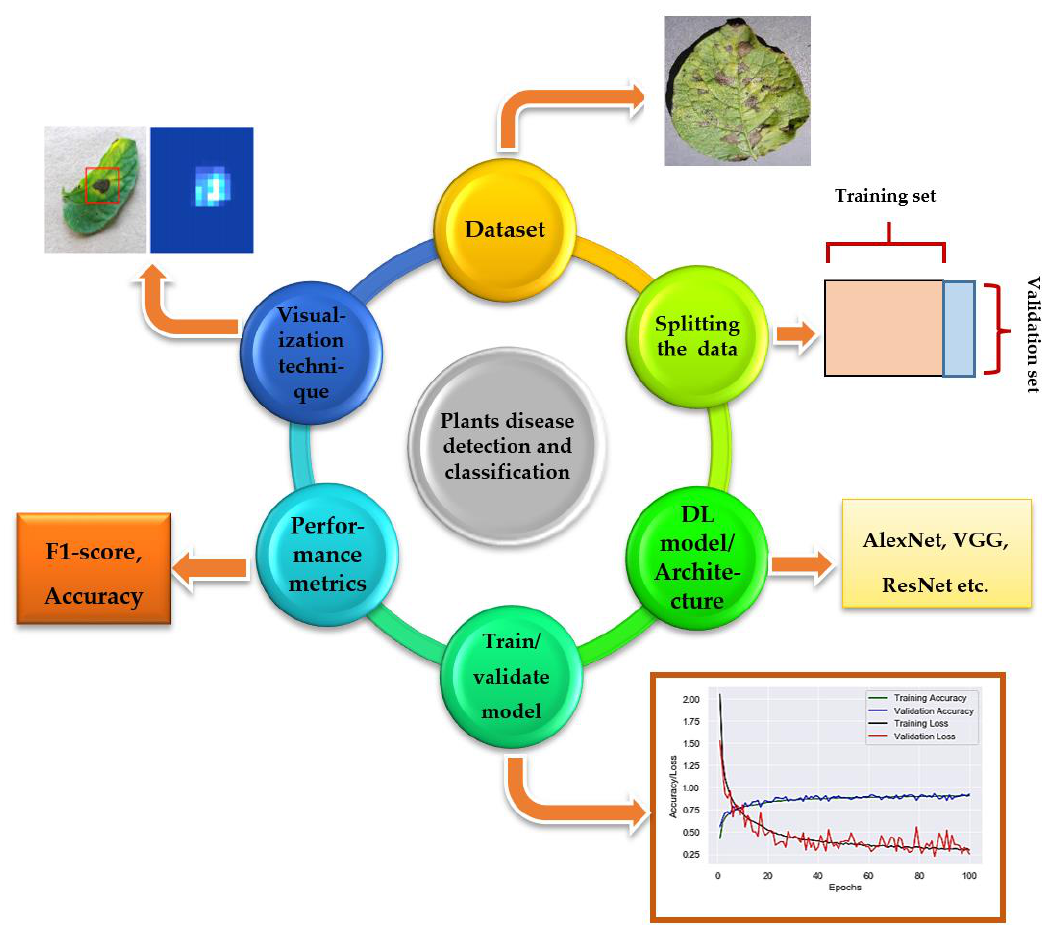
Figure 2. Flow diagram of DL implementation: First, the dataset is collected [25] then split into two parts, normally into 80% of training and 20% of validation set. After that, DL models are trained from scratch or by using transfer learning technique, and their training/validation plots are obtained to indicate the significance of the models. Then, performance metrics are used for the classification of images (type of particular plant disease), and finally, visualization techniques/mappings [55] are used to detect/localize/classify the images.